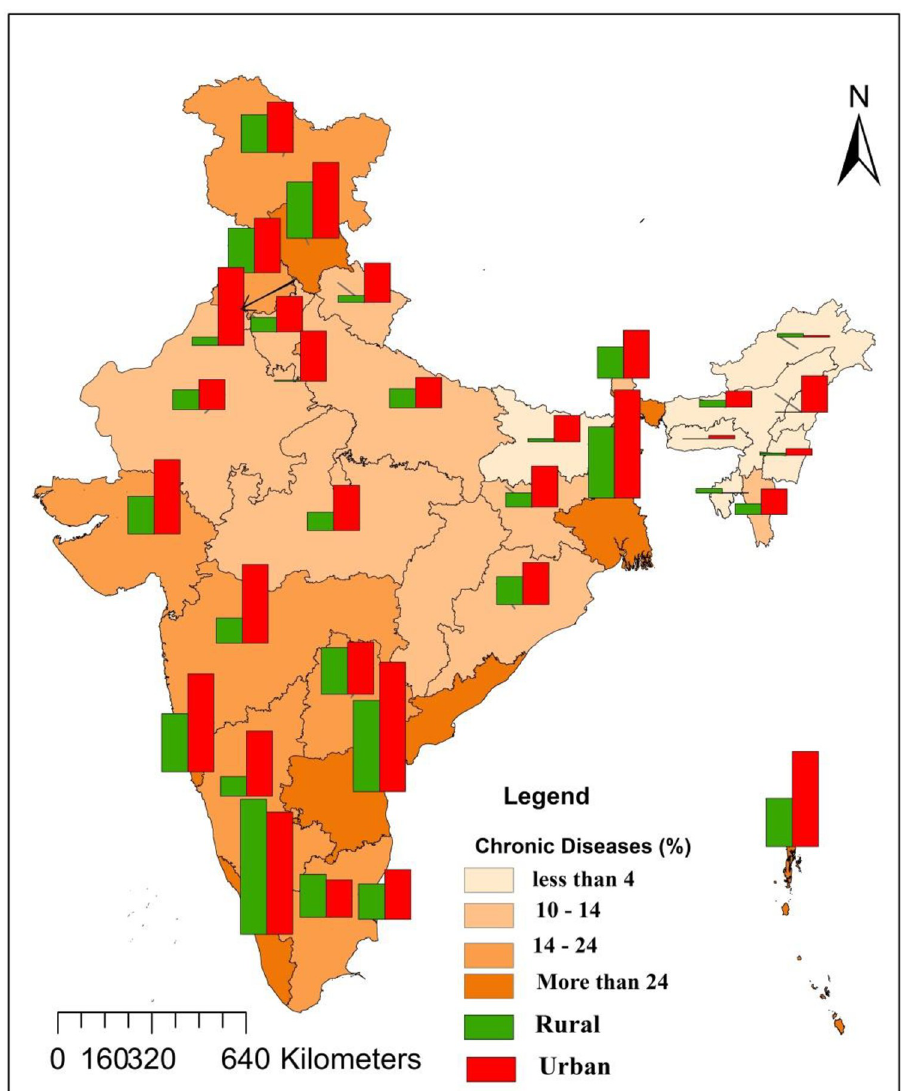
Fig 2. Prevalence map of chronic diseases among elderly population in India, 2017–18 (based on 75th round of NSS). Source: Prepared by authors.